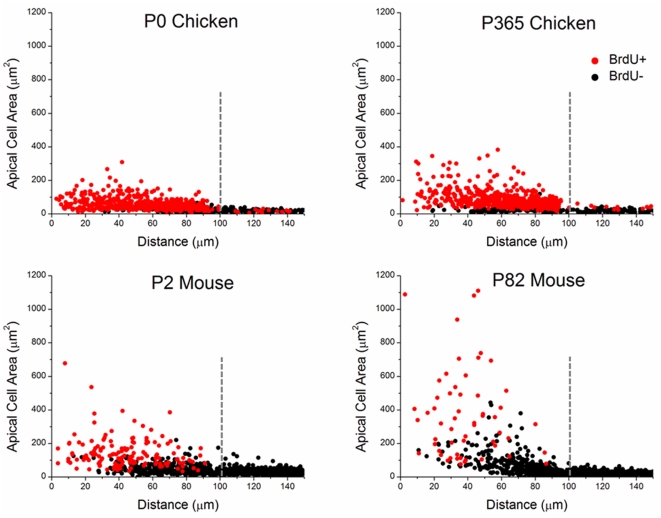
Supporting cells from chickens and mice undergo different degrees of shape change to close wounds.Shown are scatter plots of apical cell areas versus distance to the center of the excision area 48 hours after wound closure (400 cells per utricle for 3 utricles per age group). Apical cell areas were measured out to 150 µm from the center of the excision area (radius of the excision area was roughly 100 µm, shown as a dashed line). If a BrdU+ nucleus fell within the apical area, we recorded that cell as BrdU+ (BrdU+ data points are red circles, BrdU− data points are black circles). In all species and age groups, the largest cells were near the former wound center. There was a clear trend between S-phase entry and increased cell area. Supporting cells from P0 and P365 chickens underwent small shape changes with little variability, but many were BrdU+. Despite undergoing the largest shape changes, comparatively fewer cells from P82 mouse utricles were BrdU+.